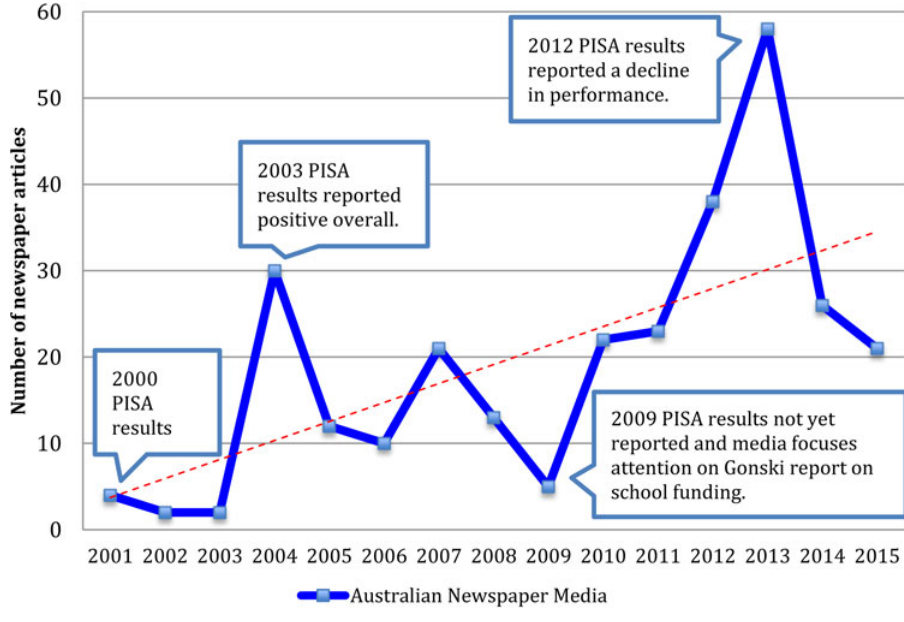
Fig. 2. Total number of Australian PISA newspaper articles published each year between 2001 and 2015 ( n